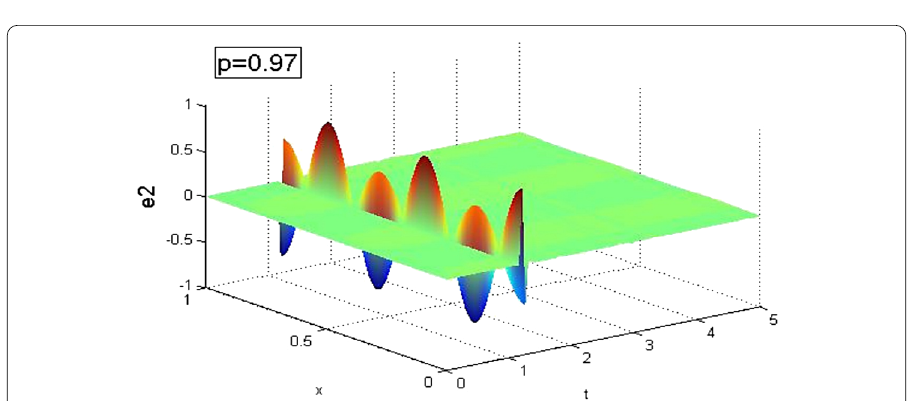
Figure 4 Time evolution of the nonlinear synchronization control error e